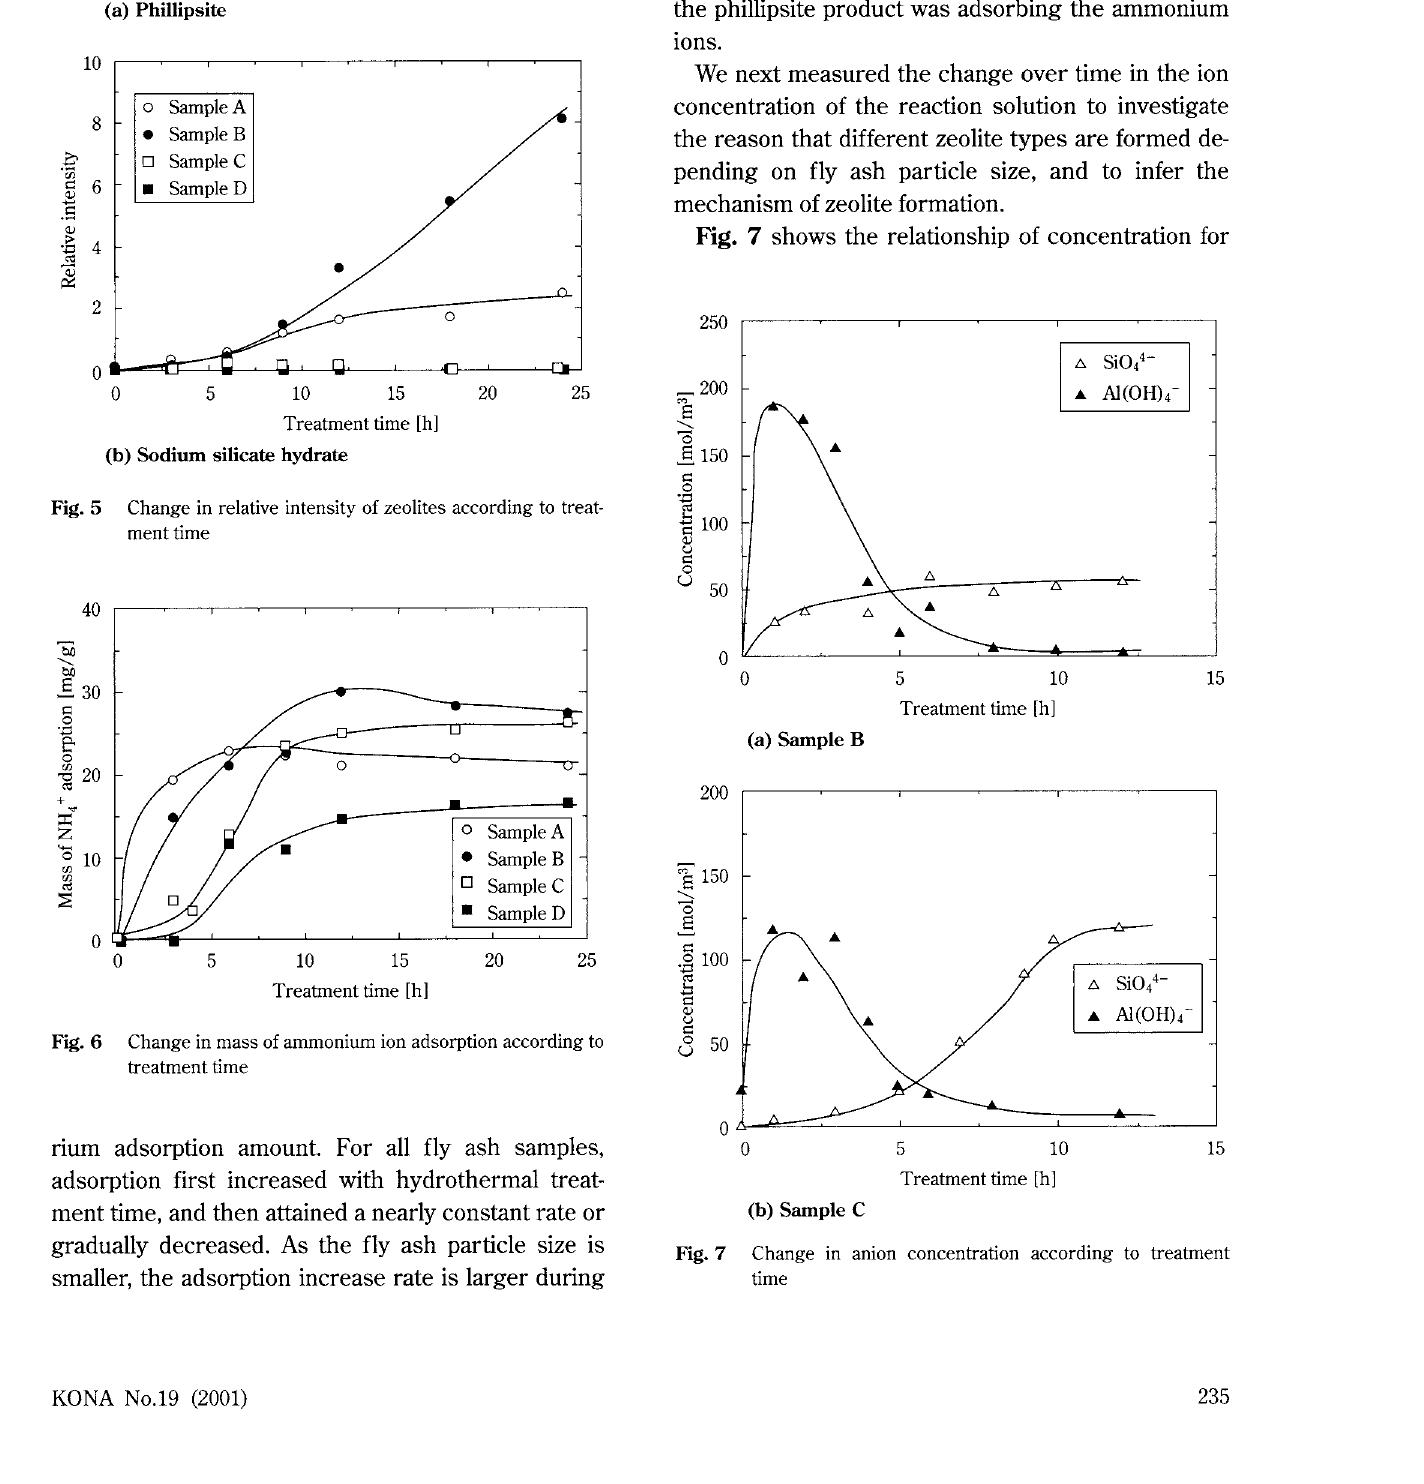
Change in anion concentration according to treatment time